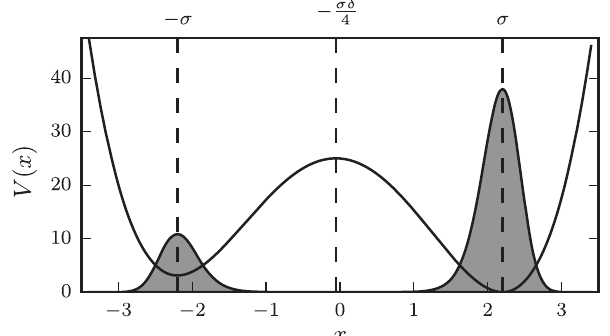
FIG. 3. Potential V ð x Þ and equilibrium distribution π ð x Þ for Brownian dynamics in double-well potential. The equilibrium distribution (shaded area) is scaled to fit the scale of the potential function. It can be seen that the equilibrium distribution is concentrated in the metastable regions around the two minima of the potential at (cid:3) σ